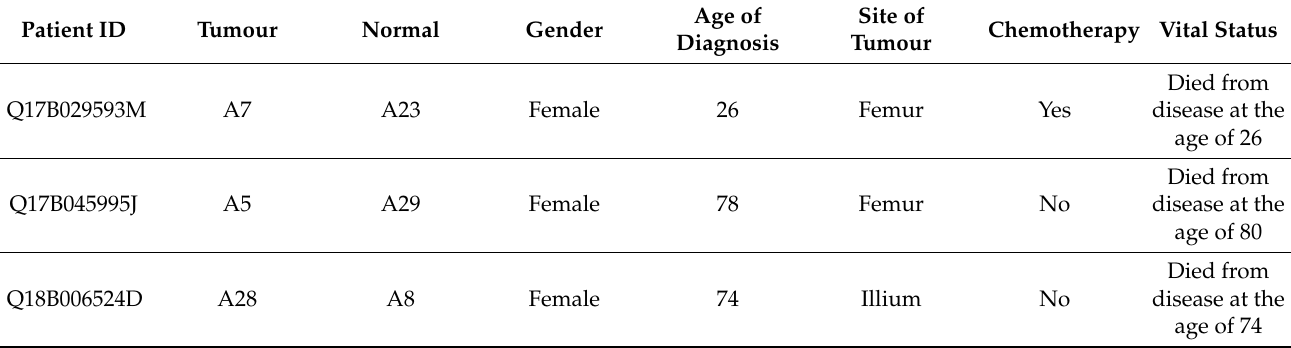
Table 2. Characteristics of osteosarcoma patients who participated in this